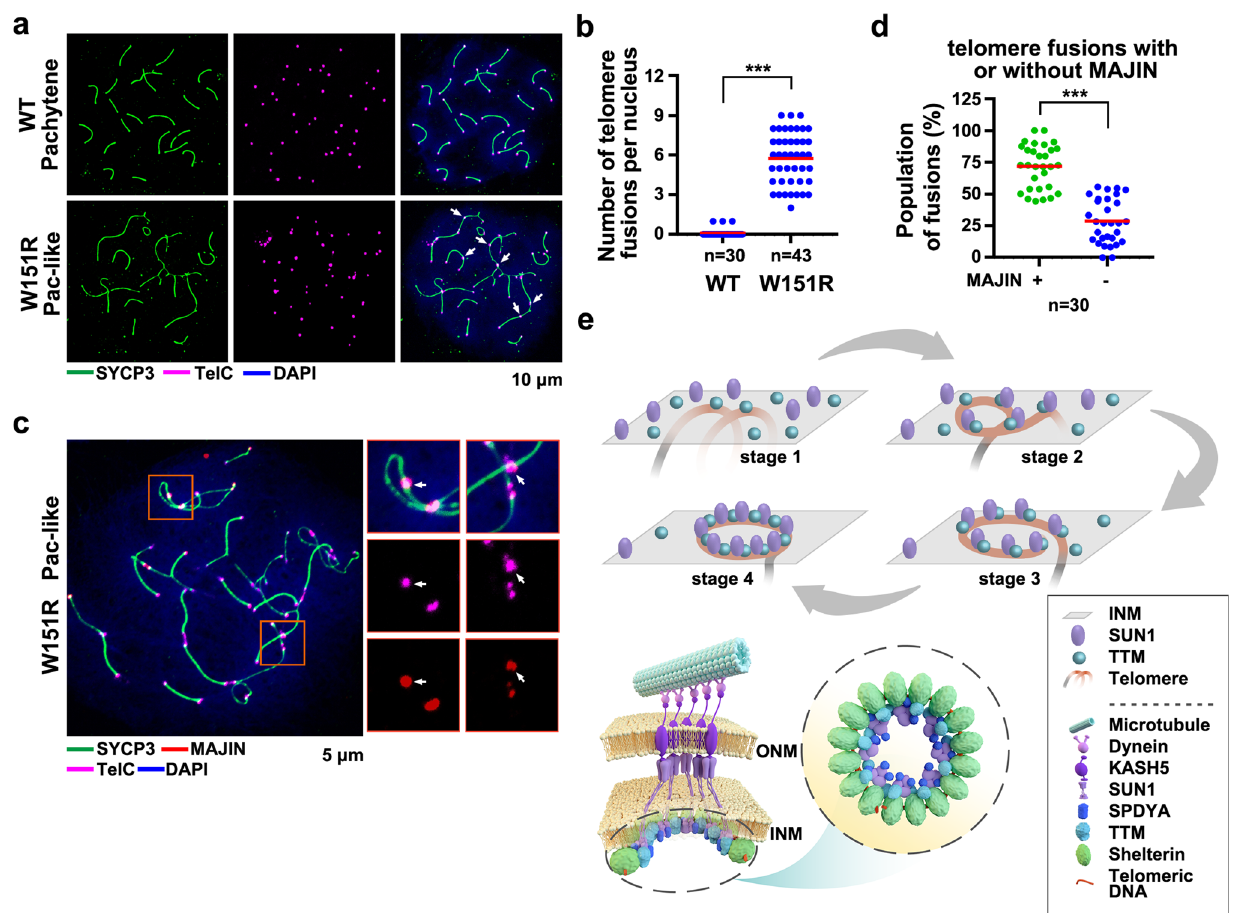
Fig. 7 Loss of the SUN1 – SPDYA interaction disrupts telomere integrity. a IF-FISH images of chromosome spreads stained for SYCP3 (green) and telomeric DNA (telC, magenta). Arrowheads indicate telomere fusions and bridges. DNA was stained by DAPI (blue). b Quanti fi cation of the number of telomere fusions and bridges per nucleus of WT ( n = 30) and W151R ( n = 43) spermatocytes in panel a . Red lines indicated the mean values. A two-sided Student ’ s t test was performed, *** P = 1.9E-24. c IF-FISH analysis of spermatocyte spreads stained for SYCP3 (green), MAJIN (red), and telomeric DNA (telC, magenta). Insets are enlarged fi gures of the framed regions containing telomere fusions. d Quanti fi cation of frequency of telomere fusions and bridges with ( + ) or without ( − ) MAJIN staining signal in W151R ( n = 30) spermatocytes from panel c . Red lines indicated the mean values. A